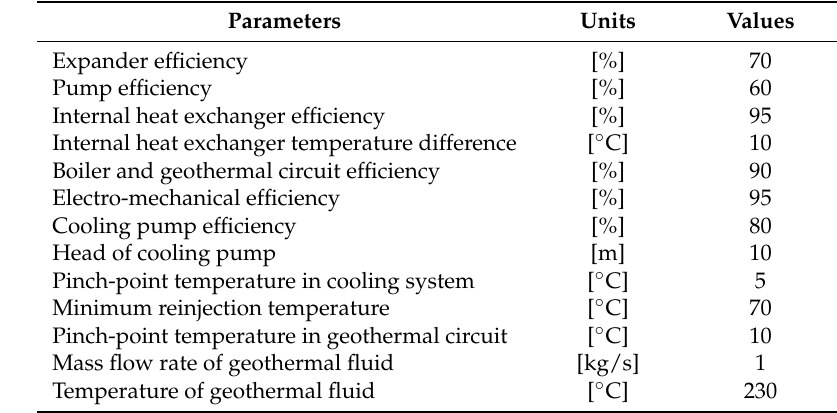
Table 2. Main assumption for the energy